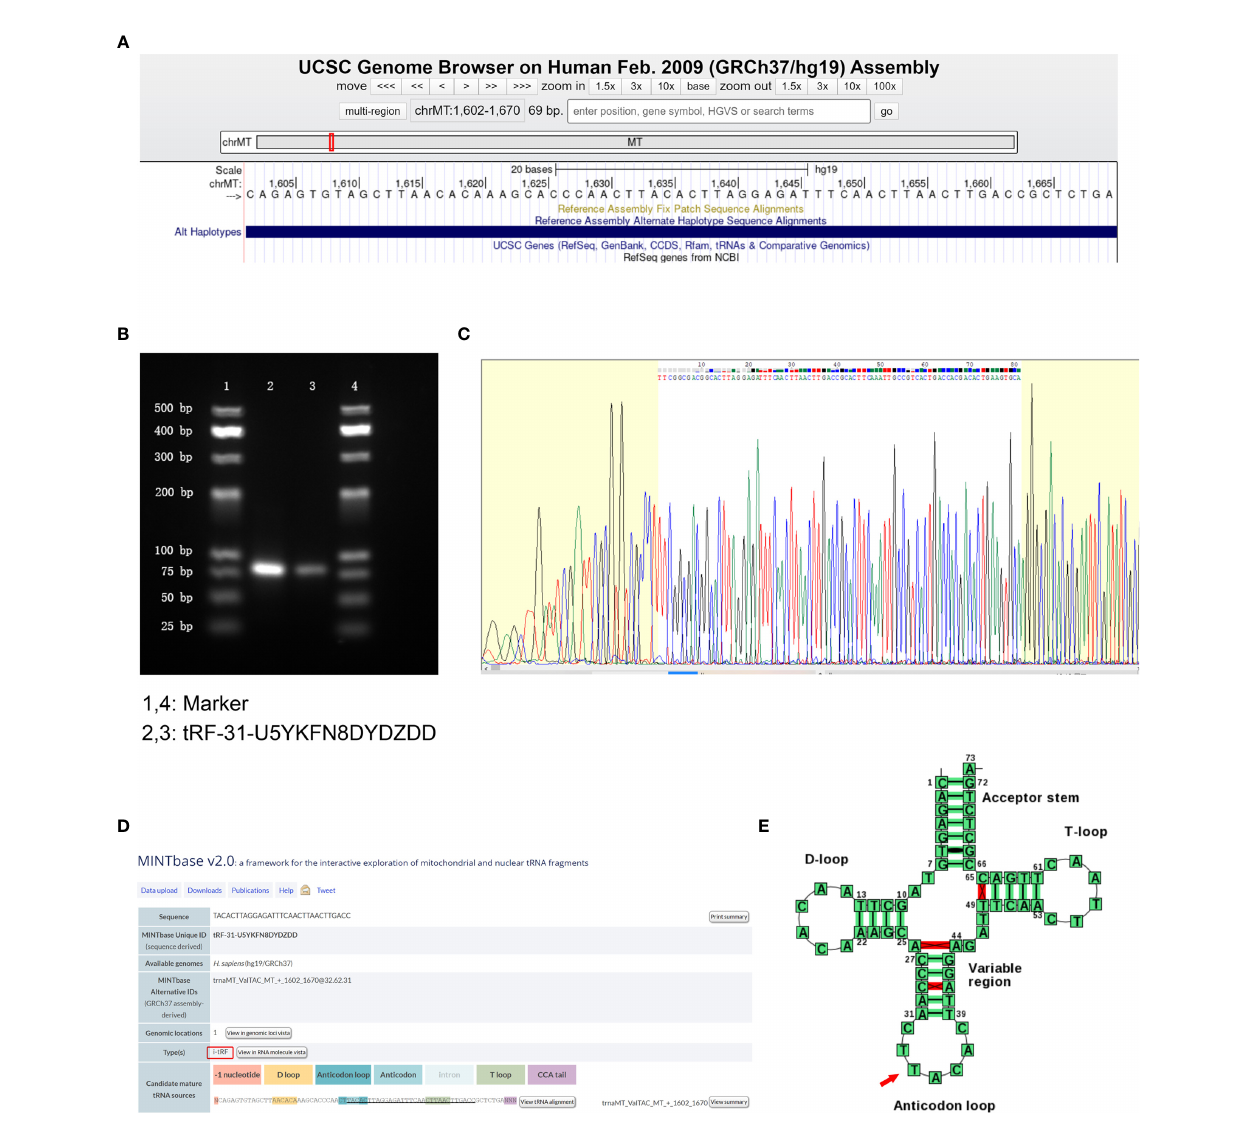
FIGURE 2 | tRF-31-U5YKFN8DYDZDD is a type of i-tRF. (A) tRF-31-U5YKFN8DYDZDD is located on ChrMT with coordinates of 1,602 – 1,670 and the length of 69 bp using the UCSC Genome Browser database (human genome build GRCh37/hg19). Search the relevant database for details. (B) The product of qRT-PCR was run on 2.5% agarose gel showing a single electrophoresis band about 80 bp in size. (C) The product of qRT-PCR was con fi rmed by Sanger sequencing, which contained the full-length sequence of tRF-31-U5YKFN8DYDZDD. (D) tRF-31-U5YKFN8DYDZDD was an i-tRF with a length of 31 nt (5 ’ - TACACTTAGGAGATTTCAACTTAACTTGACC-3 ’ ) in the MINTbase v2.0. (E) The cleavage site of tRF-31-U5YKFN8DYDZDD was located above the anticodon loop (CTTACAC) in Transfer RNA